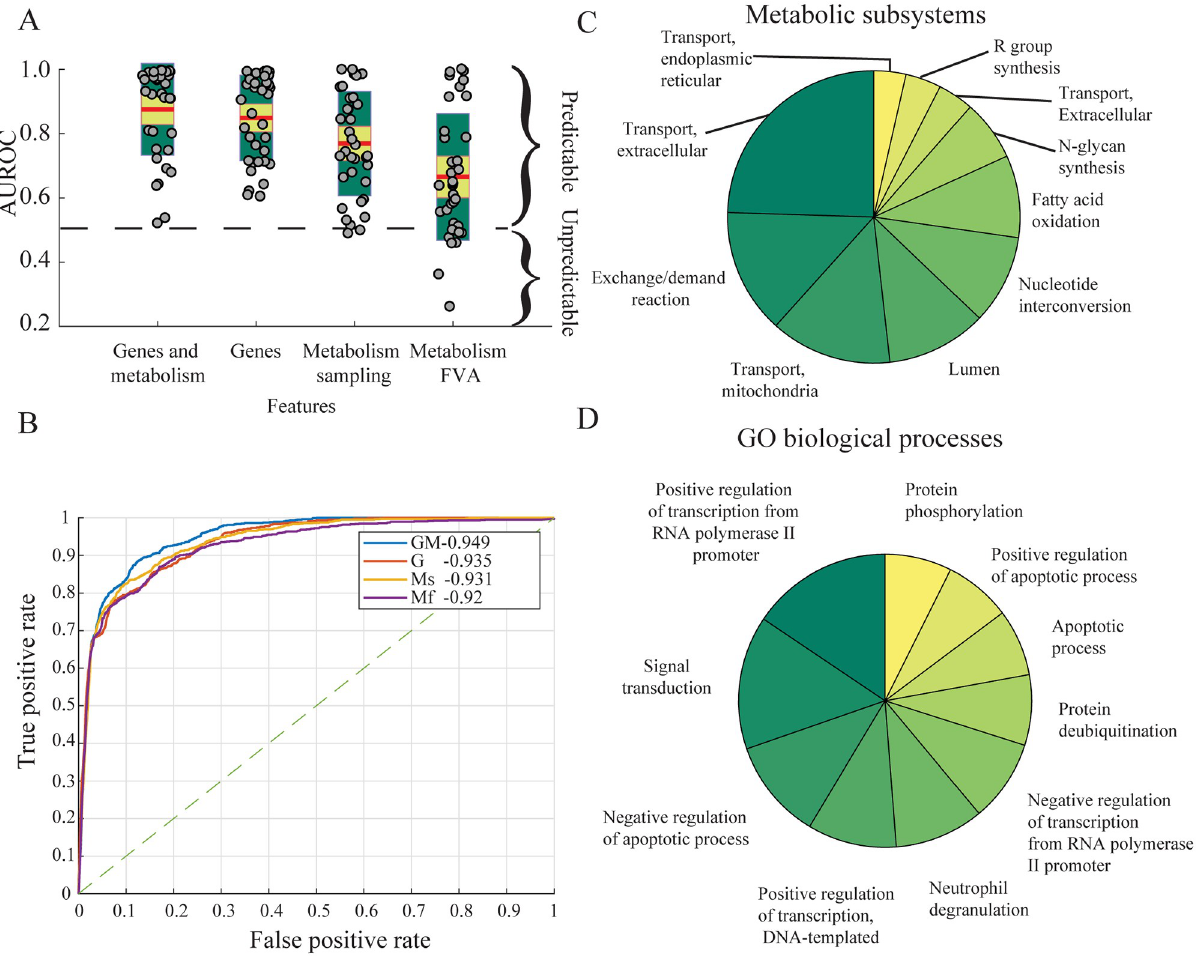
Fig 2. Evaluation metrics for the multilabel support vector machine intestinal side effects classifier. A —Comparison of individual side effect classifier predictive capability as measured by the out-of-sample AUROC using genetic, metabolic, and combined genetic and metabolic features with a 95% confidence interval around the mean in yellow and one standard deviation in green. B —ROC curve of the microaveraged multilabel SVM classifier using genes, metabolism and combined genes and metabolism as features. All the pairwise differences between the AUROC are significant at p < 0.05 using the Hanley and McNeil test [33], except the difference between the classifier using sampled reactions as features and the classifier using gene expression as features. Unlike panel A that summarizes the AUROC curves where each class is treated equally, the micro-average allows to correct for the class imbalance. C —Top ten enriched metabolic subsystems and D —GO biological process terms ranked by the number of metabolic and genetic representatives. G stands for genes, Ms for metabolism sampling, Mf for metabolism FVA, and GMs for genes and metabolism sampling.